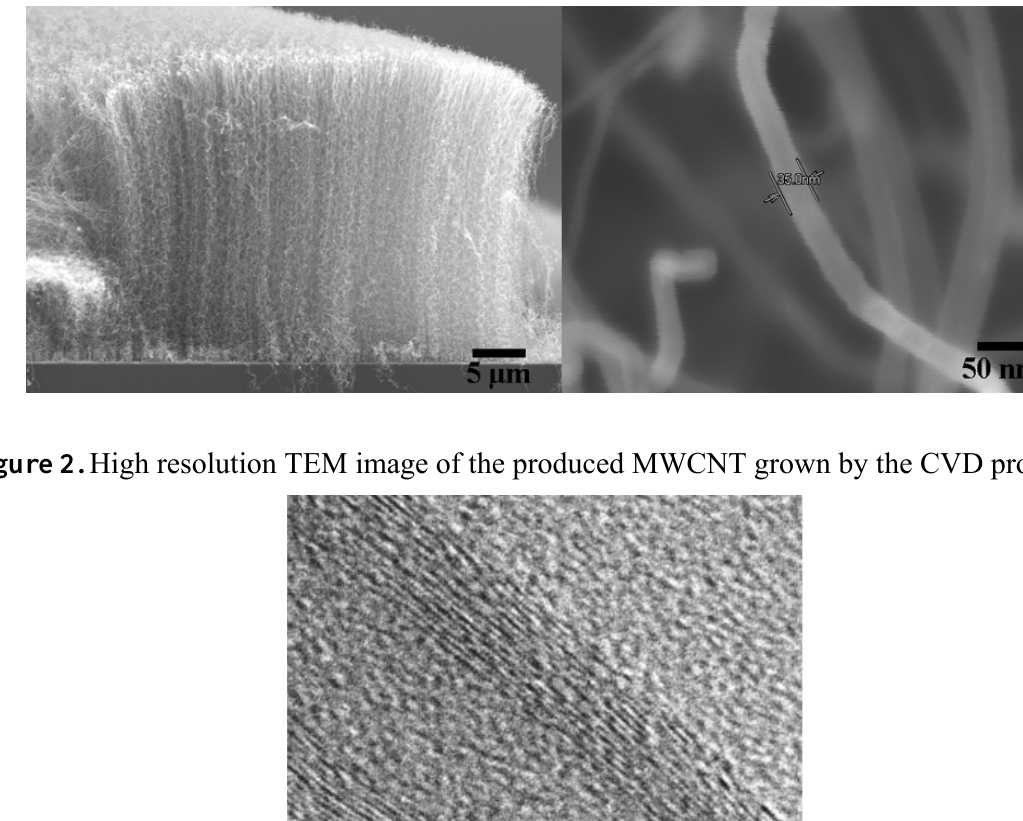
Figure 1. SEM images of the produced MWCNTs grown by the CVD process.